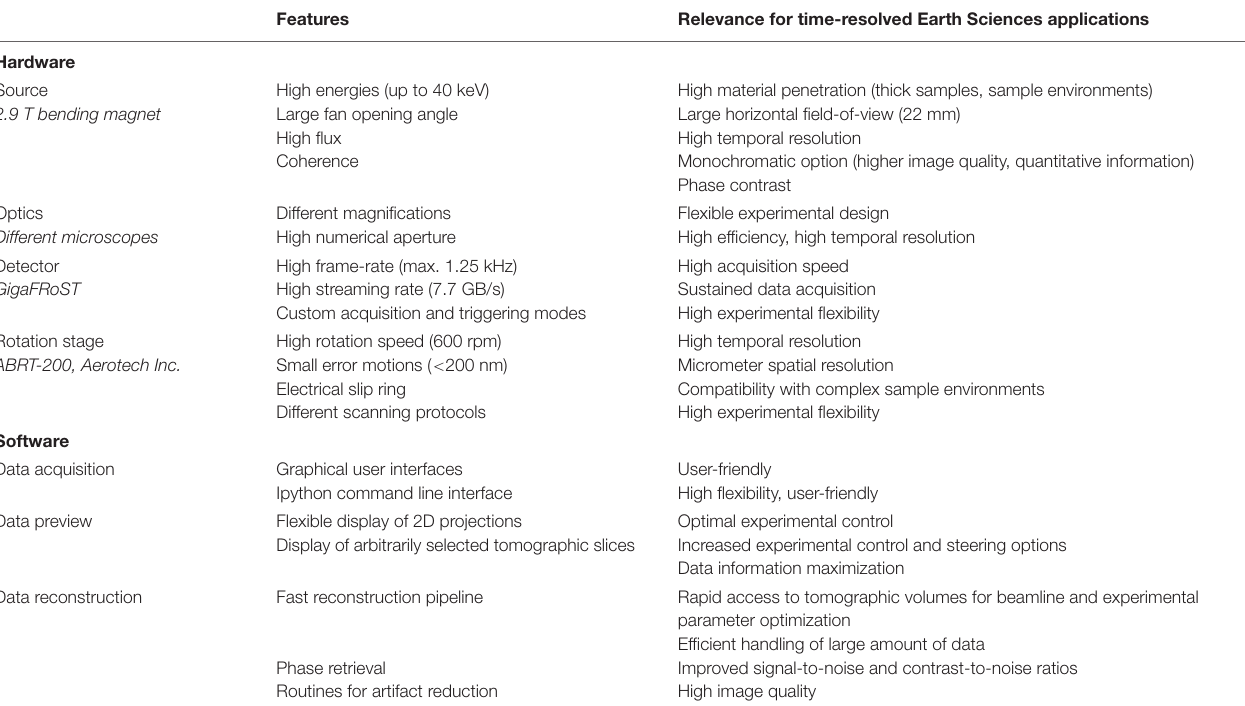
TABLE 1 | Summary of the features of recent hardware and software developments at the TOMCAT beamline and their relevance for time-resolved Earth Sciences